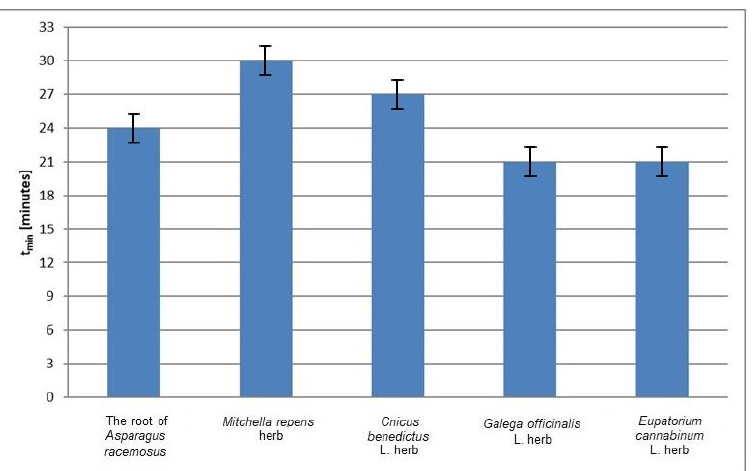
Figure 4. Comparison of the times ( t min ) to reach the minimum value by the relative amplitudes (A/A DPPH ) of the EPR spectra of DPPH free radicals interacting with infusions of the root of Asparagus racemosus , Mitchella repens herb, Cnicus benedictus L. herb, Galega officinalis L. herb, and Eupatorium cannabinum L. herb. A—amplitude of the EPR line of DPPH free radicals in contact with the tested infusion. A DPPH —amplitude of the EPR line of DPPH free radicals in the reference solution. Data for the infusions obtained from the plant materials not exposed to UV